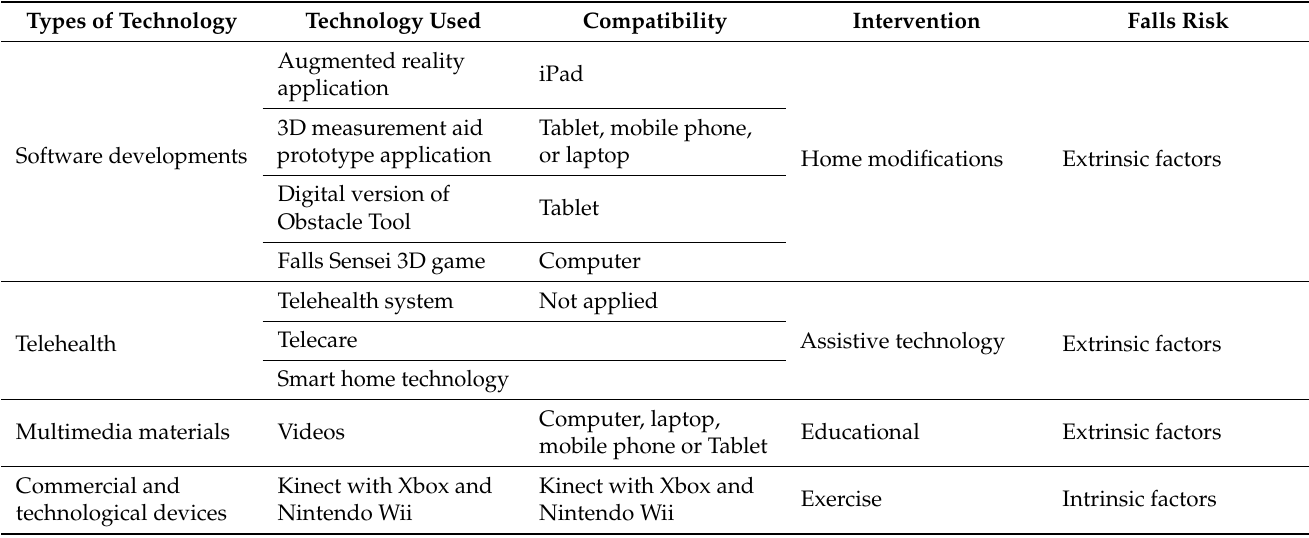
Table 3. Relationships between Section 3.2.2. and Section